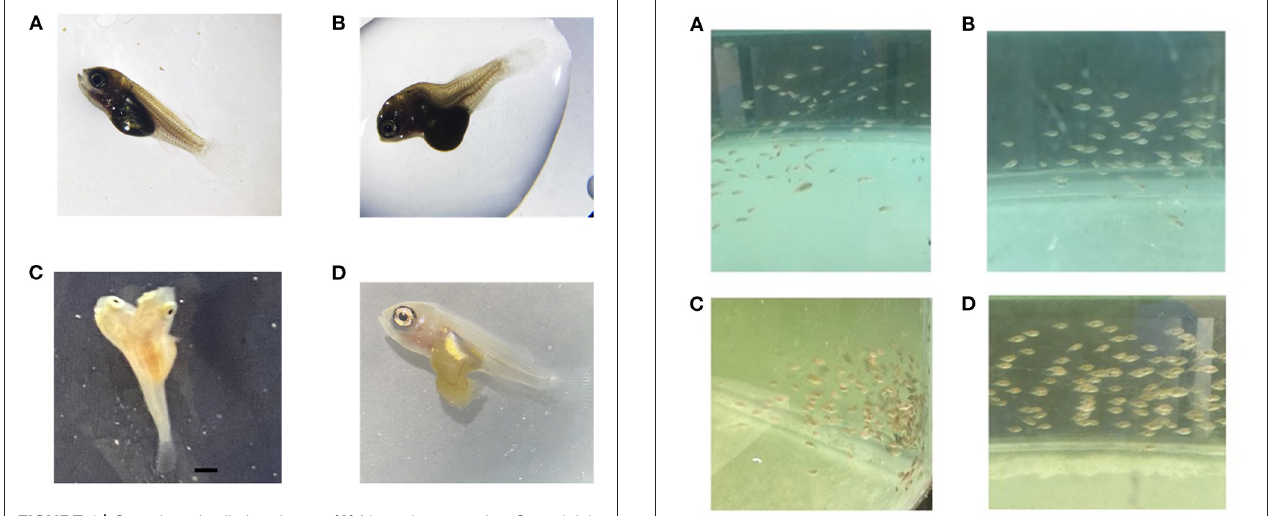
FIGURE 4 | Oreochromis niloticus larvae. (A) Normal, exposed to Caesalpinia spinosa aqueous extract. (B–D) Positive control (cyclophosphamide 1.25 µ g/ml), spinal malformation, larvae with two heads, and malformed yolk sac, respectively (Stereoscope MOTIC, SMZ-168, China,1.5 × , View a and b with backlight, view c and d with light outside). Bar: 1mm.